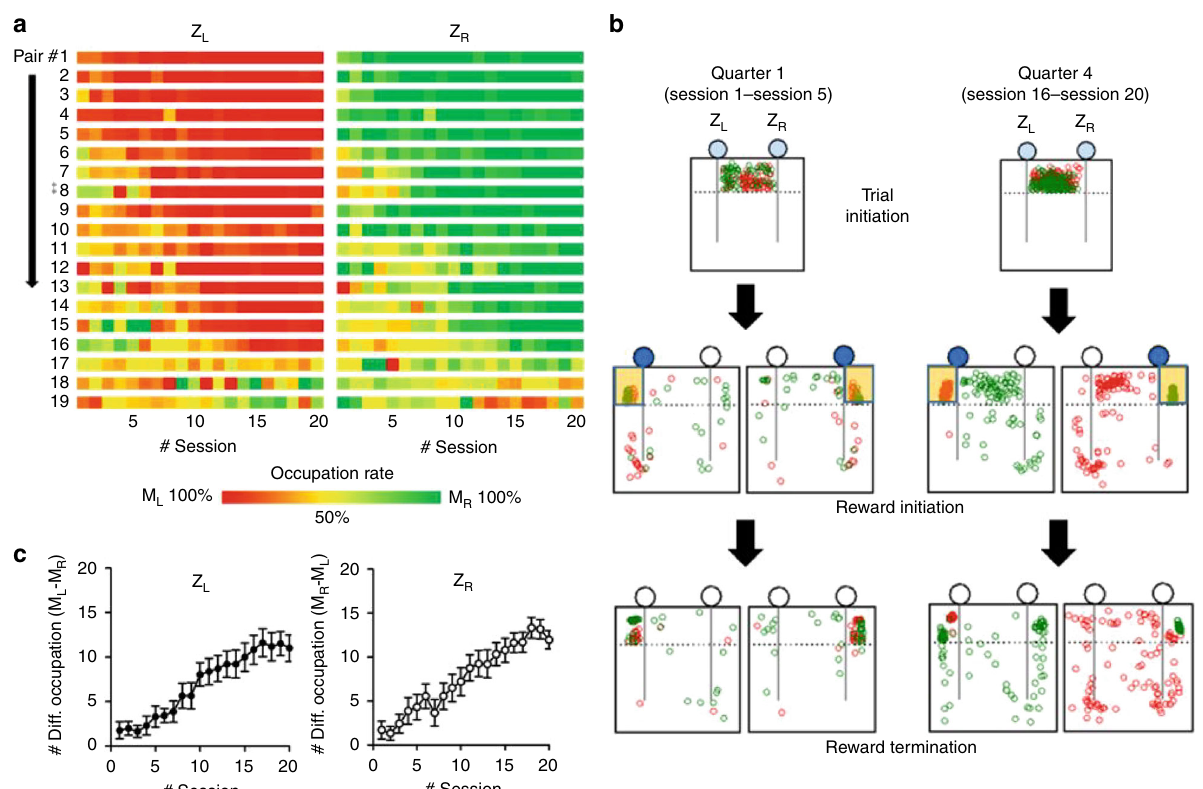
Fig. 3 Development of behavioral patterns during con fl ict resolution test under the WBS conditions. a Pixel-based representation of the reward zone occupation rate by the two competing mice through the 20 sessions for each of the 19 pairs: Deep green, 100% by M R ; deep red, 100% by M L ; mixed colors representing different proportions by the two. Z L , left reward zone, Z R , right reward zone. b Pictorial presentation of the position of the mouse at given time points. Each circle (green, M R ; red, M L ) indicates the position of a mouse at the designated time point, trial initiation, reward initiation and reward termination. Left panel shows summation of the fi rst quarter, from session 1 to 5. Right panel, the last quarter, from session 16 – 20. The ‡ eighth pair on the Fig. 3a is used as the representative sample here. c The mean value of the differential occupation of each reward zone by the two mice throughout the sessions. For Z L , number of occupation by M L — number of occupation by M R . For Z R , in the opposite